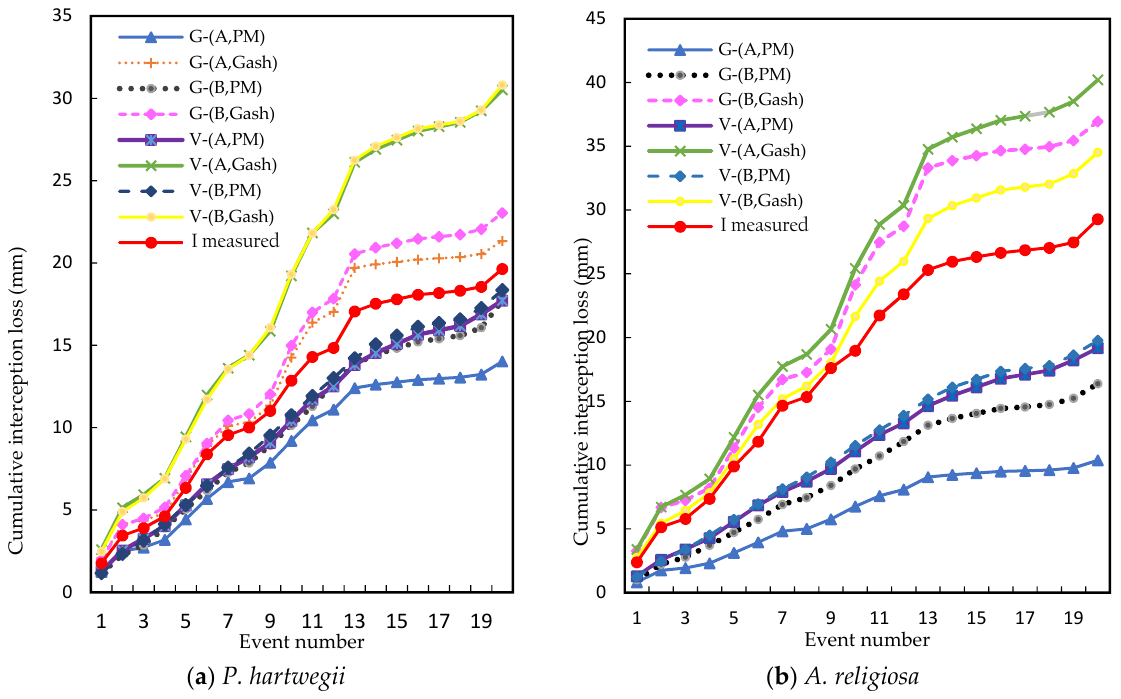
Figure 6. Cumulative measured and simulated rainfall interception for both calibration and validation groups for P . hartwegii ( a ) and for A. religiosa ( b ).